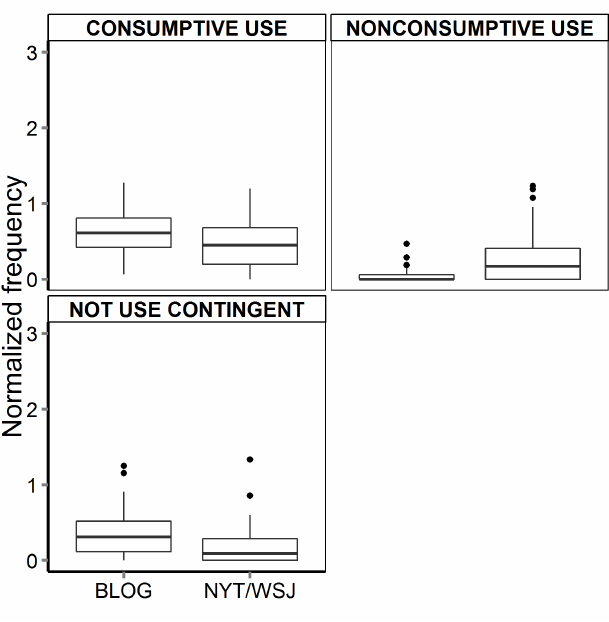
Table 4 . Sequence of multivariate analysis of variance results for